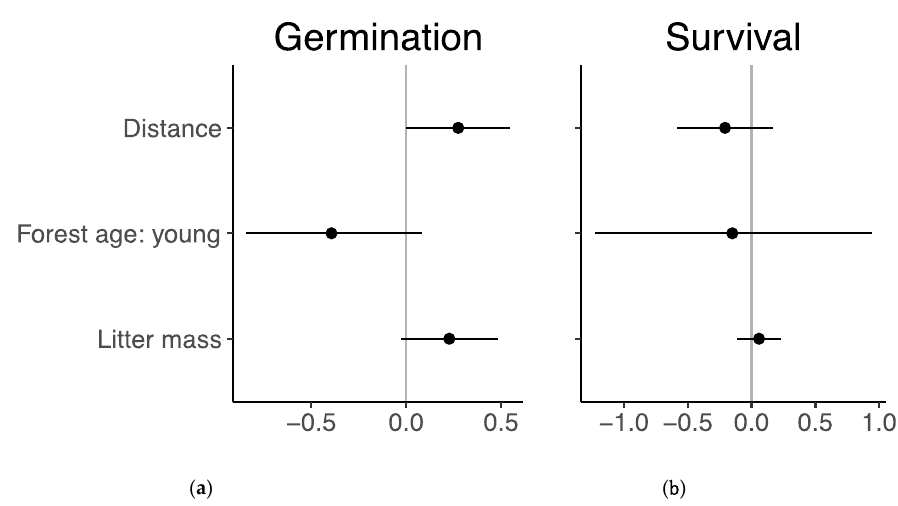
Figure 3. Coefficient estimates ±95% confidence intervals of scaled coefficients for distance, forest successional age, and litter mass on ( a ) germination of seeds and ( b ) survival of seedlings.